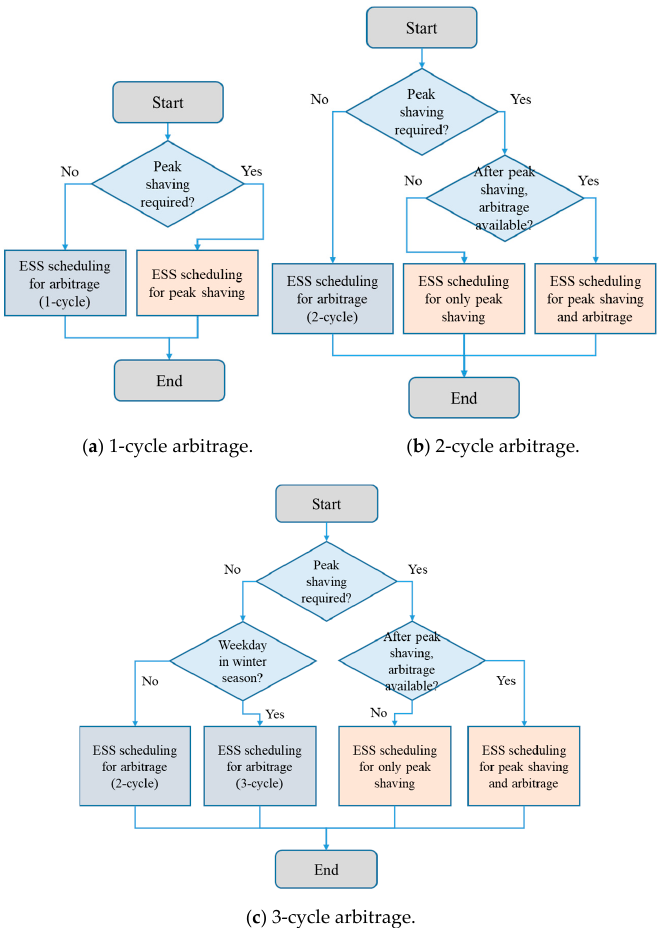
Figure 1. A flowchart of the operational strategy of ESS under the TOU tariff structure in South Korea: